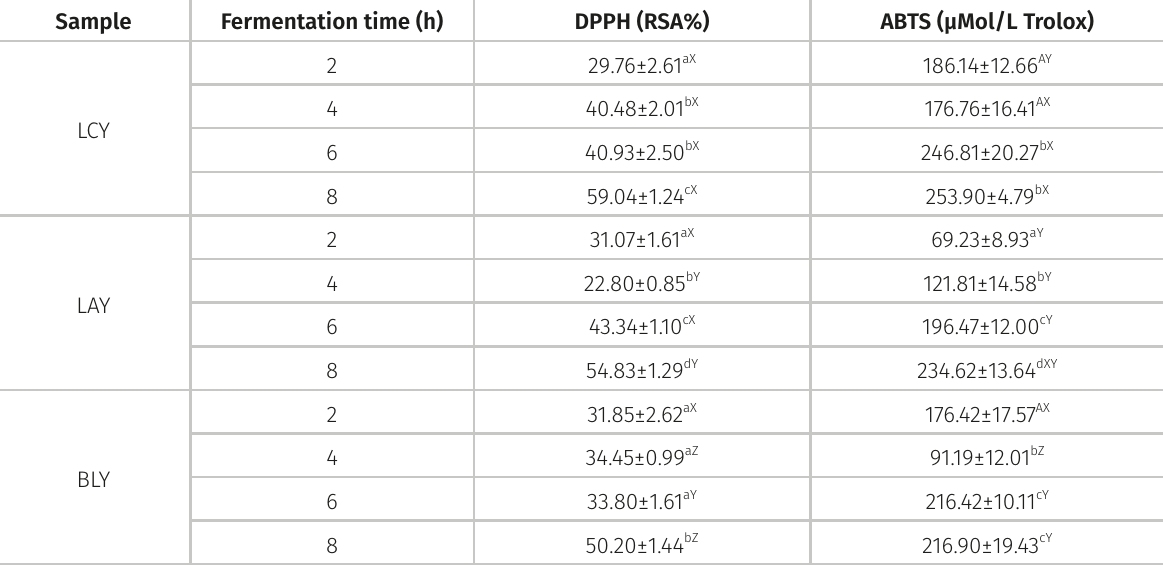
Table III. Antioxidant activities of LCY, LAY and BLY samples during the fermentation time.